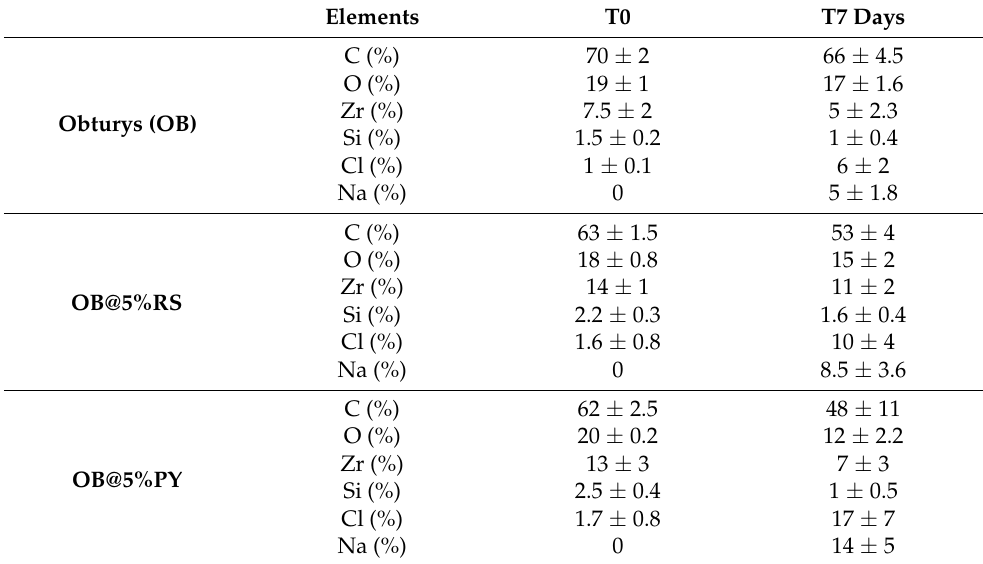
Table 3. Relative compositions of the experimental sealers as measured by means of EDX at T0 and after 7 days of immersion in PBS.